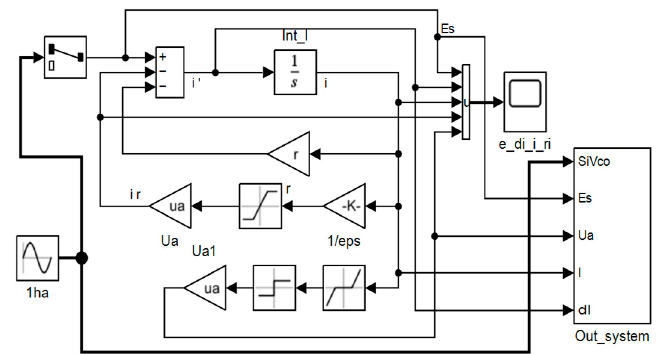
Figure 2. Operational diagram of the circuit model from Figure 1.